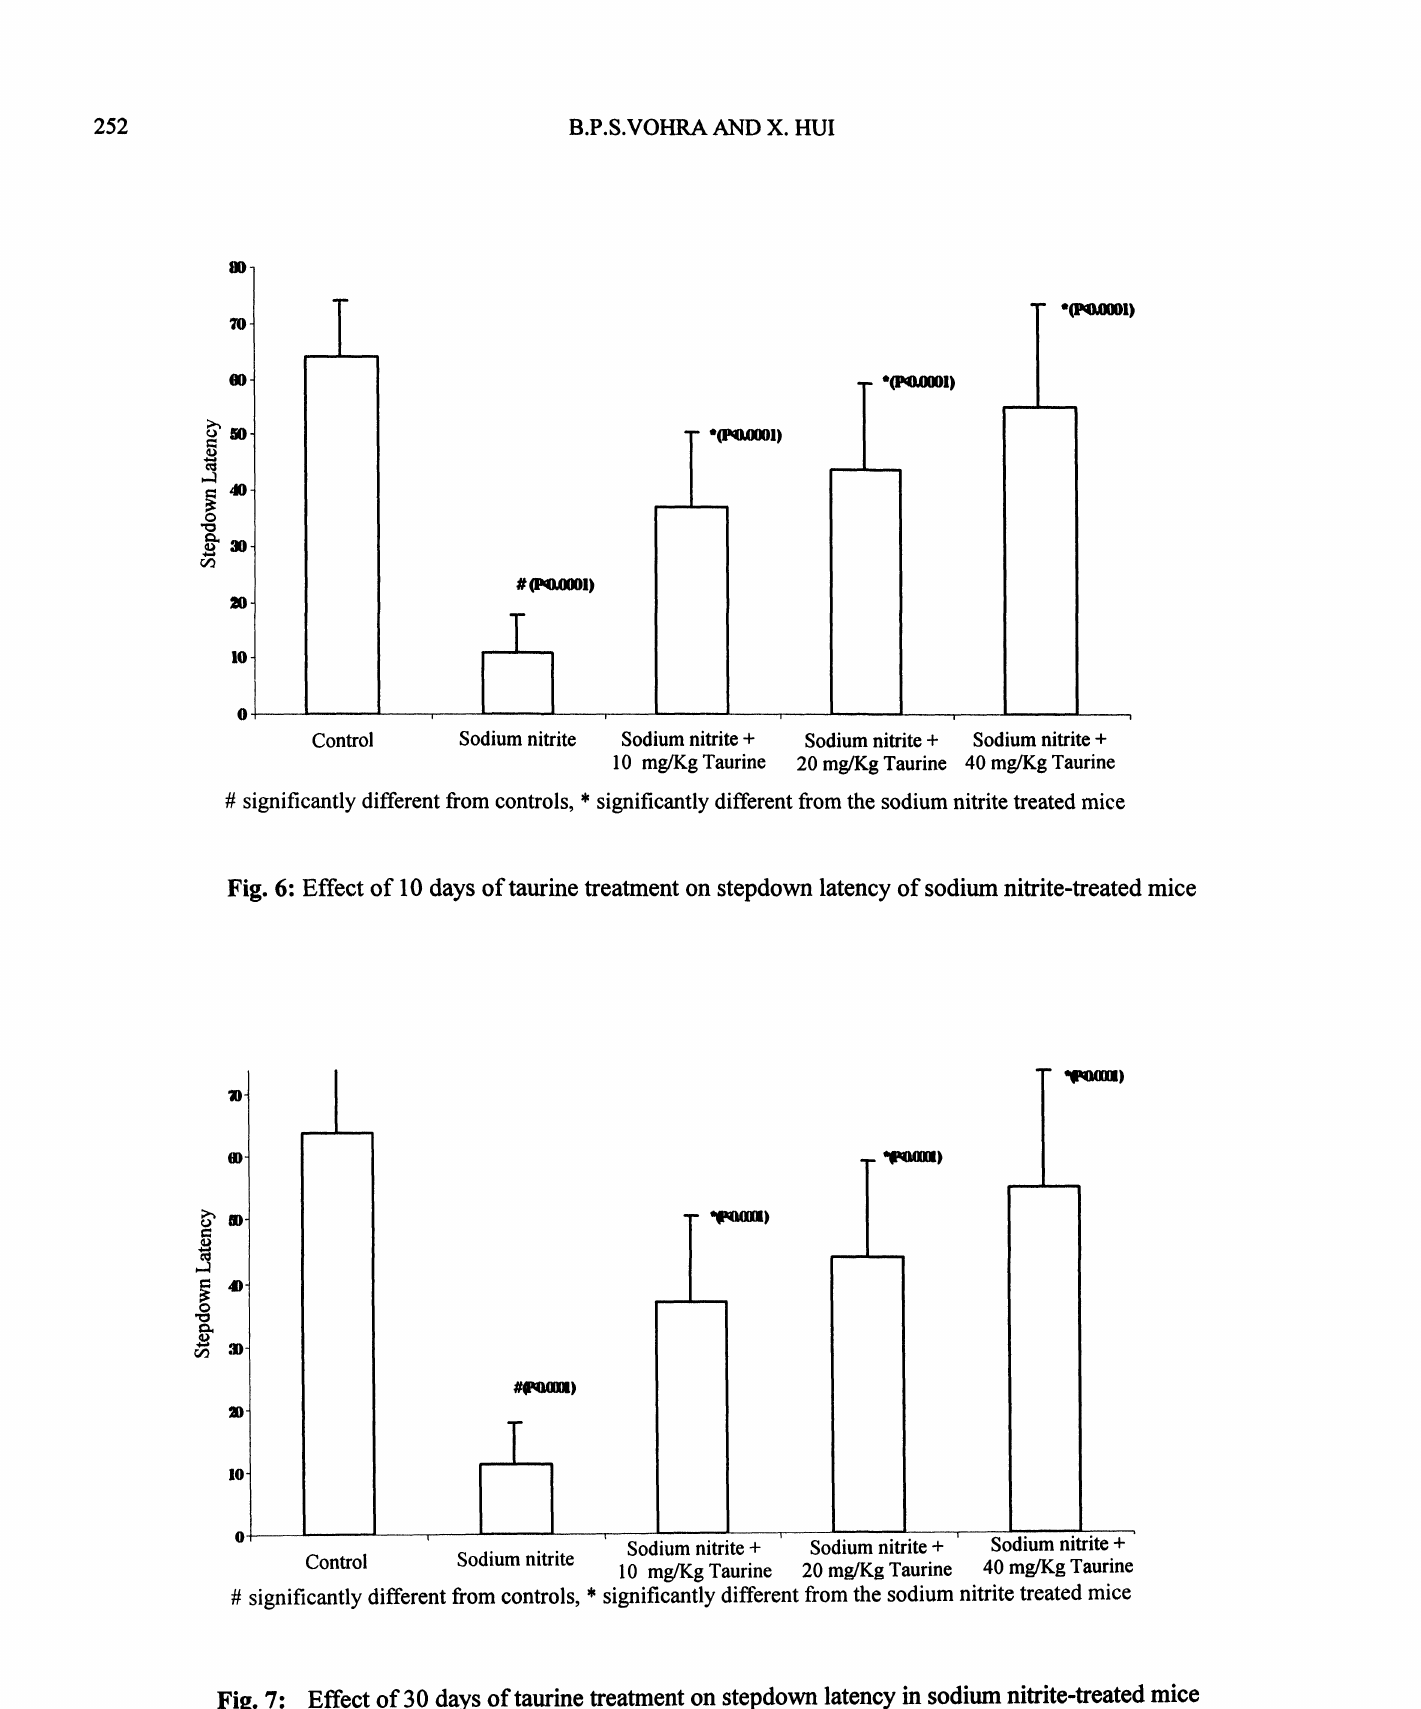
Fig. 7: Effect of 30 days of taurine treatment on stepdown latency in sodium nitrite-treated